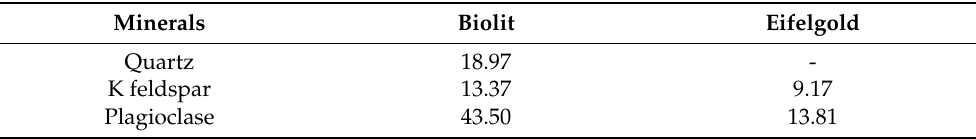
Table 2. Mineralogical composition of the two rock powders ‘Biolit’ and ‘Eifelgold’, all values in wt%. Minerals Biolit Eifelgold